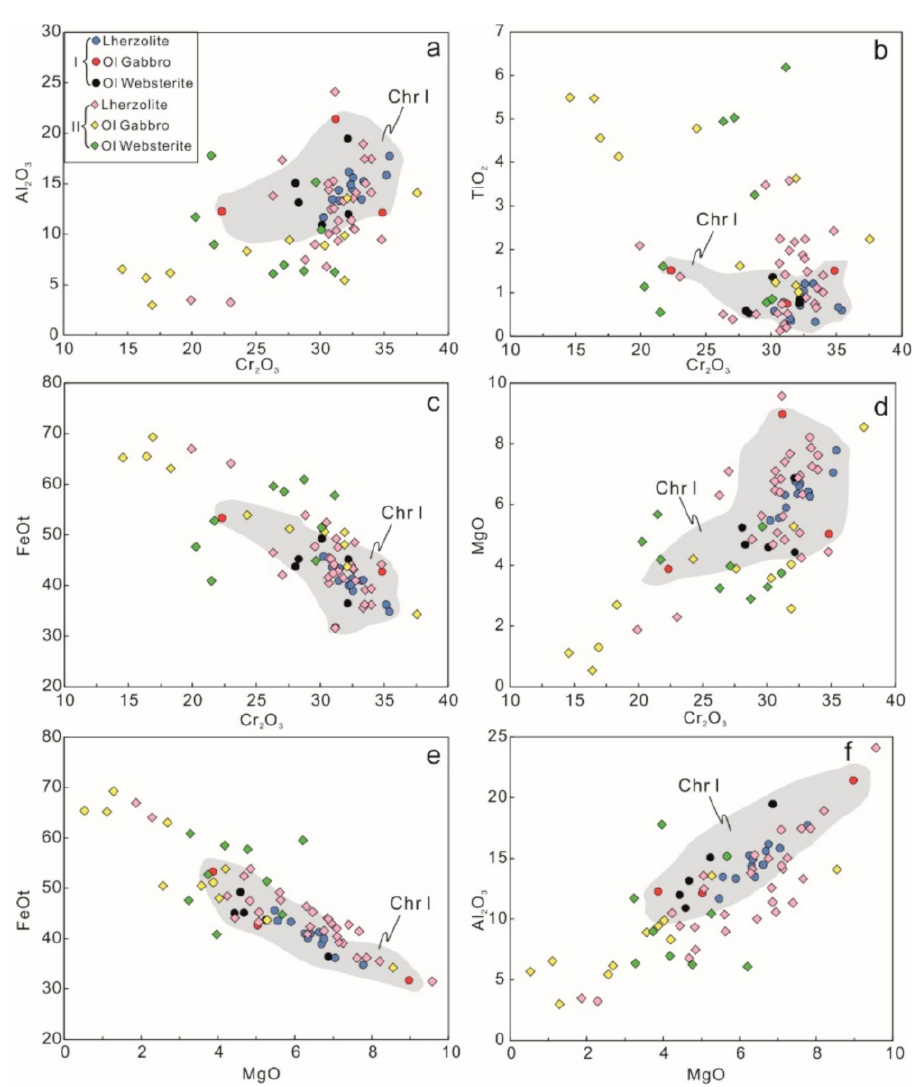
Figure 4. Major oxide variations for two types of chromite and di ff erent rocks in the Baixintan mafic-ultramafic intrusion (wt%): the shadow area is roughly defined by primary type I chromite (Chr I, circles). ( a ) Plot of Al 2 O 3 -Cr 2 O 3 ; ( b ) Plot of TiO 2 -Cr 2 O 3 ; ( c ) Plot of FeOt-Cr 2 O 3 ; ( d ) Plot of MgO-Cr 2 O 3 ; ( e ) Plot of FeOt-MgO; ( f ) Plot of Al 2 O 3